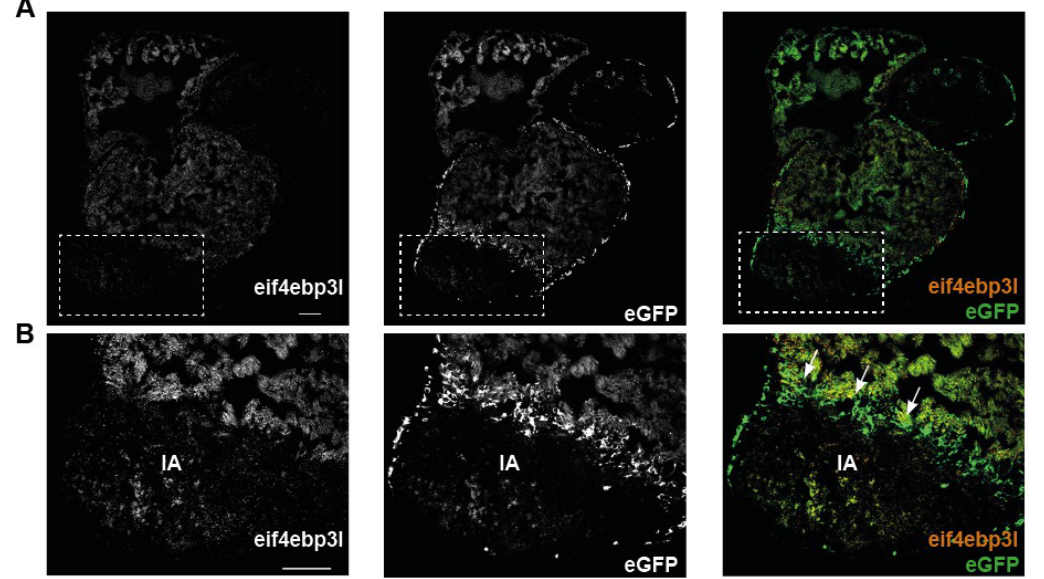
Figure 2. At day three after cryoinjury eif4ebp3l is downregulated in the injured area (IA). ( A , B ) Images of RNAscope in situ hybridizations (ISH) for eif4ebp3l (left panels, orange in the right panel) and eGFP (middle panels, green in the left panel) on cryosections of Tg(fli1:eGFP) zebrafish heart three days post cryoinjury (dpci). ( A ) Overview of the whole zebrafish heart; the IA is outlined with the dotted box. Eif4ebp3l was highly expressed in the healthy myocardium and downregulated in the IA. ( B ) Higher magnifications of the IA. eGFP was highly expressed in the border zone, where the formation of new endothelial vessels originated. Eif4ebp3l was co-located to these eGFP-positive endothelial cells in the border zone (white arrows), whereas in the center of the injured area its mRNA expression was strongly downregulated. Scale bar = 100 µm.